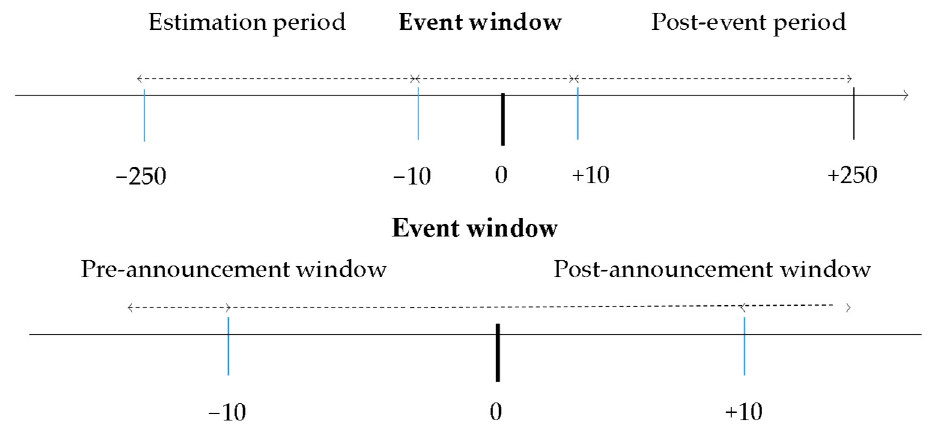
Figure 1. Event study window for cumulative abnormal return.